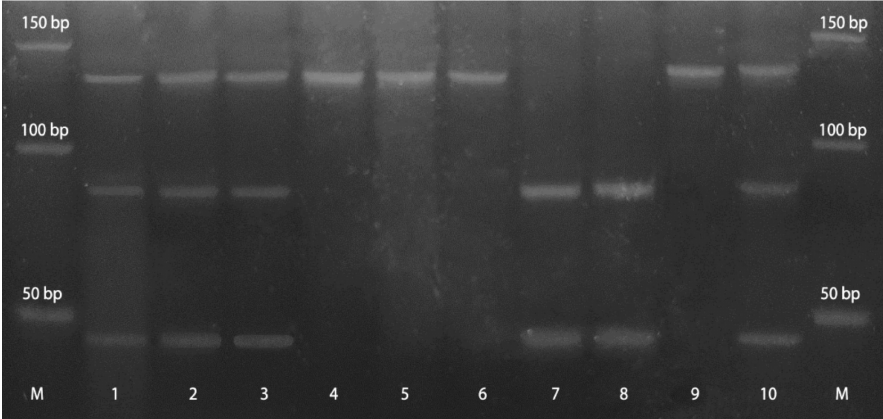
Figure 6. APC exon 11/RsaI/RFLP in glioblastoma samples is demonstrated. Lane M-standard DNA 50 bp ladder (Invitrogen); lanes 1, 2: heterozygous sample (tumor and blood), both alleles, cut and uncut, are visible; lane 3: possible restriction site introduced in tumor sample; lane 4: paired homozygous sample (blood); lanes 5, 6: homozygous sample (tumor and blood), uncut alleles are visible; lanes 7, 8: homozygous sample (tumor and blood), cut alleles are visible; lane 9: LOH, cut allele is missing; lane 10: corresponding informative blood sample, both alleles, cut and uncut, are